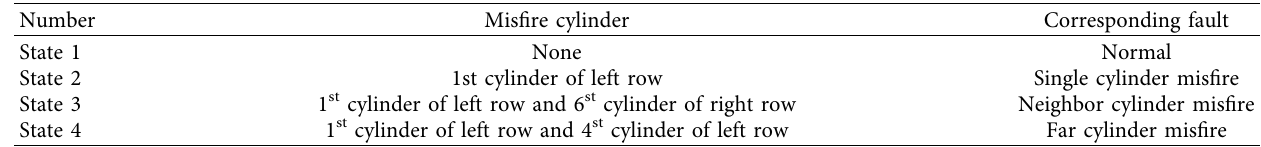
Figure 6: The measuring positions. Table 1: Diesel engine misfire fault